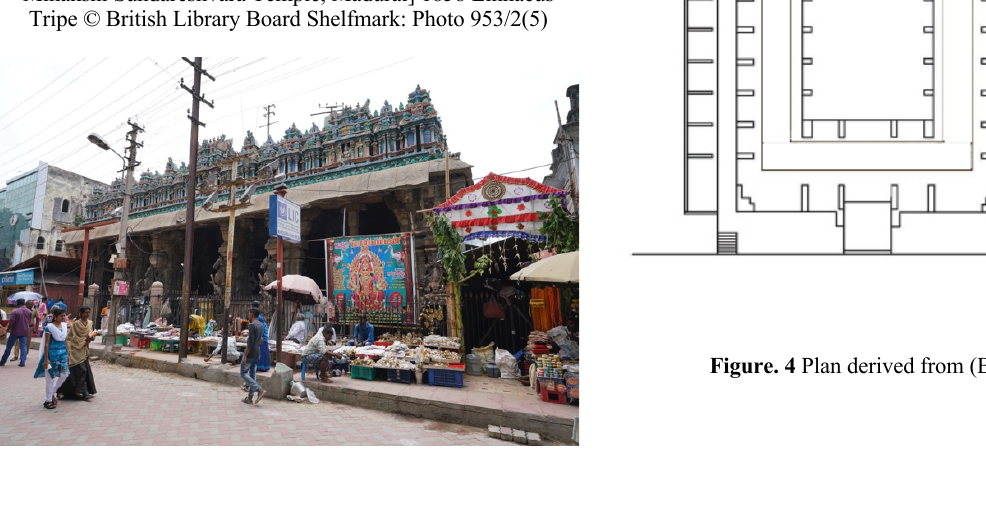
Figure 2 . West front of the Puthu Mandapum. [Pudu Mandapa,